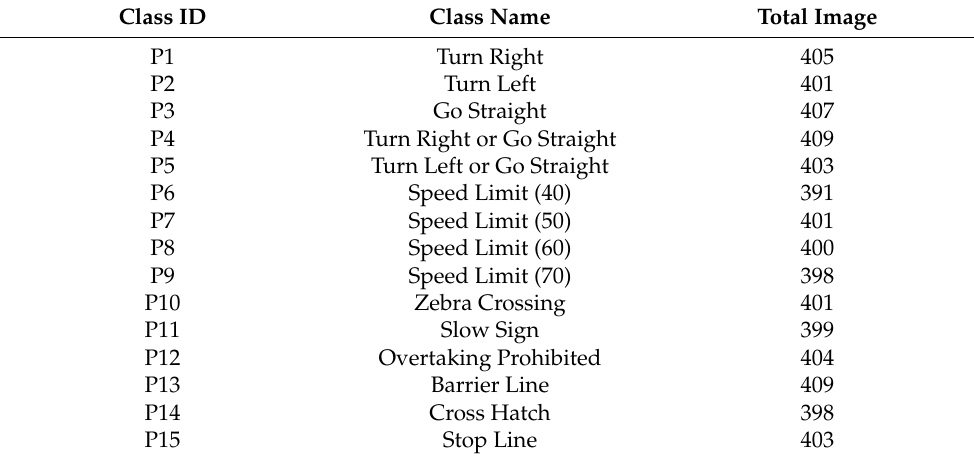
Figure 2. TRMSD sample image. Table 2. TRMSD Dataset.